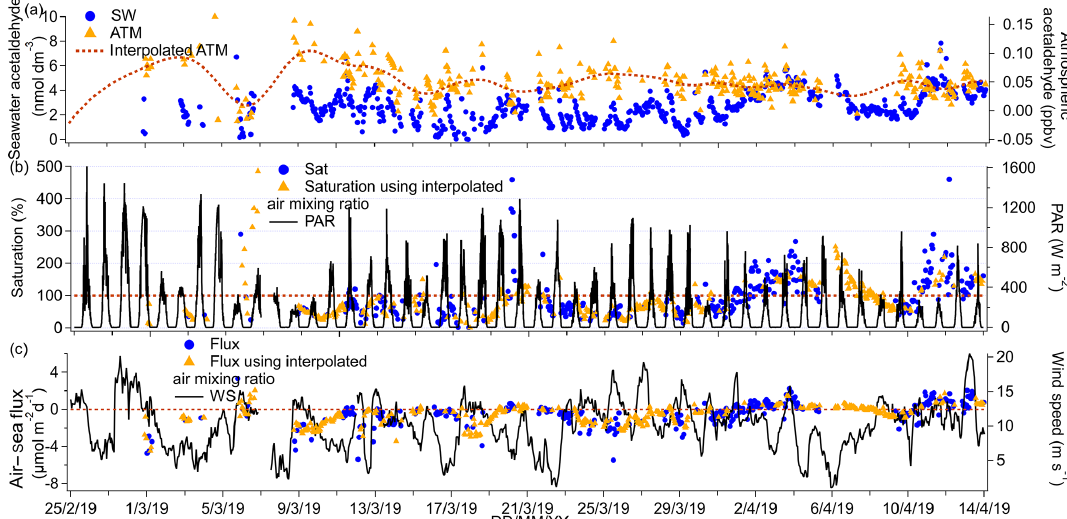
Figure 8. (a) Time series of acetaldehyde seawater (SW) concentrations as well as measured and interpolated marine boundary layer air mixing ratios (ATM and interpolated ATM). (b) Time series of acetaldehyde saturations determined using the measured air mixing ratio and interpolated air mixing ratio and time series of chlorophyll a . (c) Time series of air–sea acetaldehyde fluxes calculated using the measured air mixing ratio and interpolated air mixing ratio and time series of wind